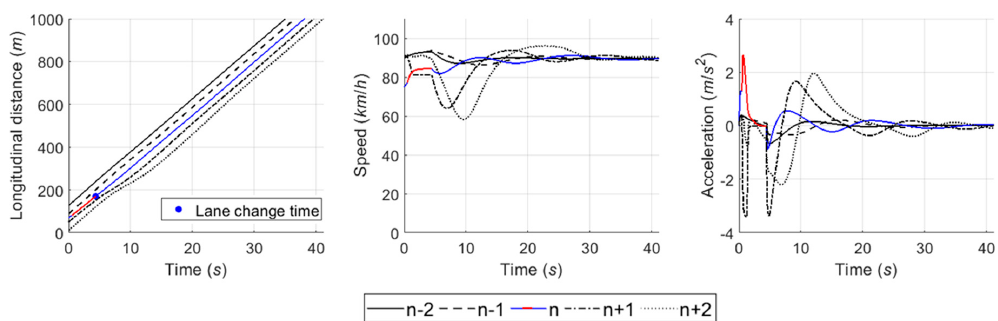
Figure 16. Graphical representation of simulation results in case 1. Note that a red solid line indicates simulation data of the SV (vehicle n ) during game period, whereas a blue solid line shows the SV’s data in simulation time except game period.